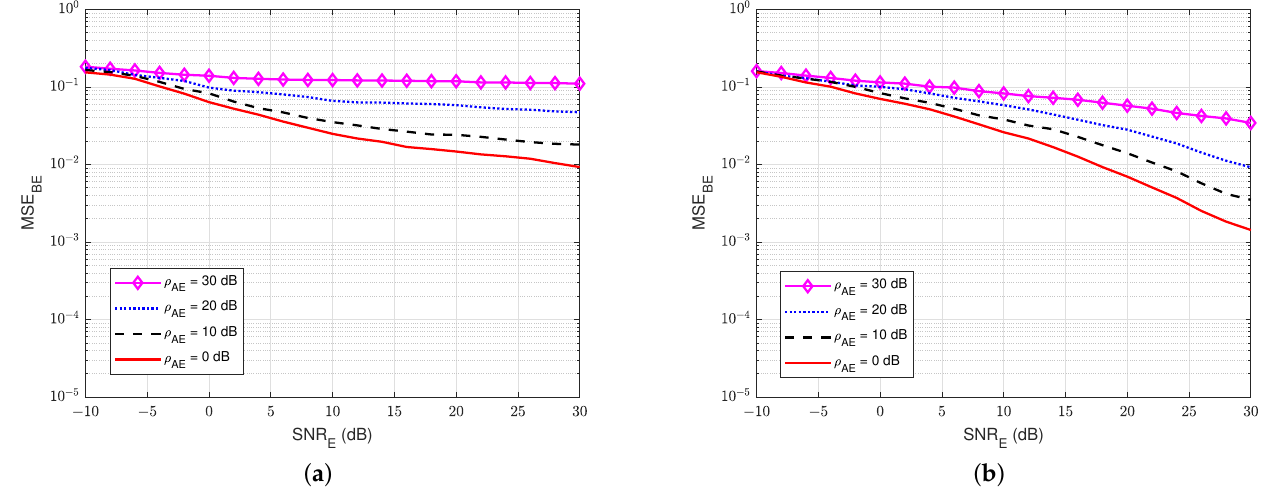
Figure 18. MSE BE versus SNR E , ρ EE = 30 dB in case of an active eavesdropper: ( a ) Blind without feedback; ( b ) Semi-blind without